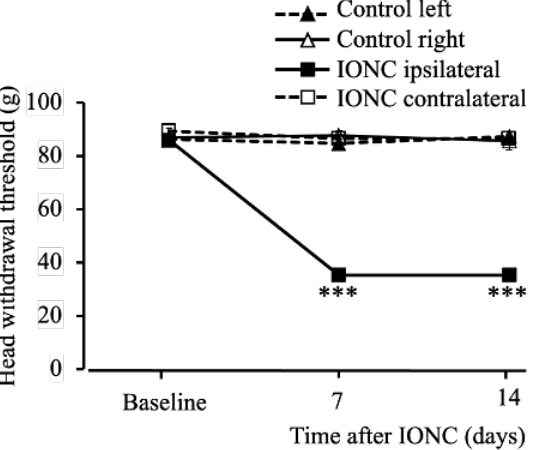
Figure 1. Head withdrawal threshold to mechanical stimuli. Bilateral head withdrawal threshold to mechanical stimuli in whisker pad area on day 7 and 14 after surgery (infraorbital nerve constriction (IONC)). In the IONC group, head withdrawal thresholds were significantly decreased in the ipsi- lateral side after day 7 and 14 of surgery compared on to the contralateral side. The head withdrawal thresholds are represented as mean ± standard error of the mean (SEM). n = 6 per group. *** p < 0.001, repeated measures analysis of variance followed by Tukey’s HSD test.